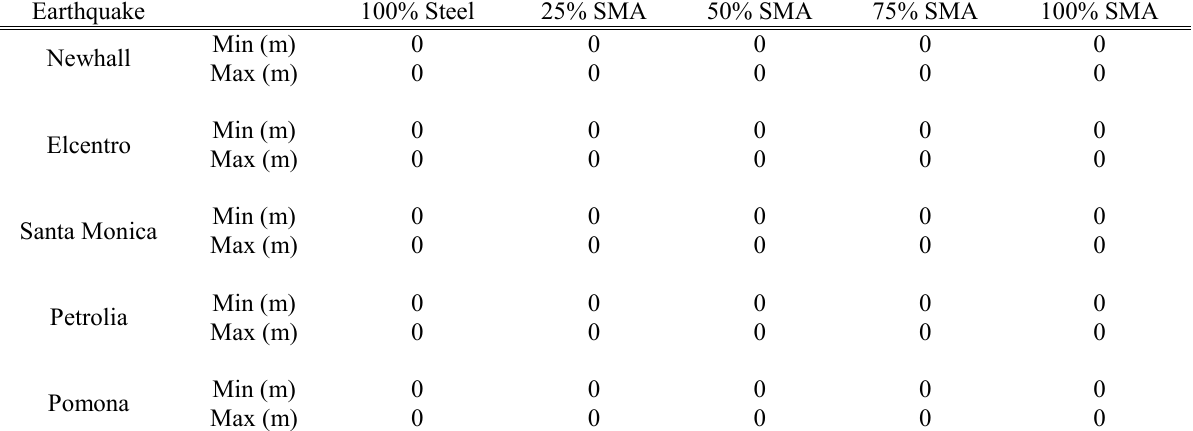
Minimum and Maximum Displacements at Joint J1 Earthquake